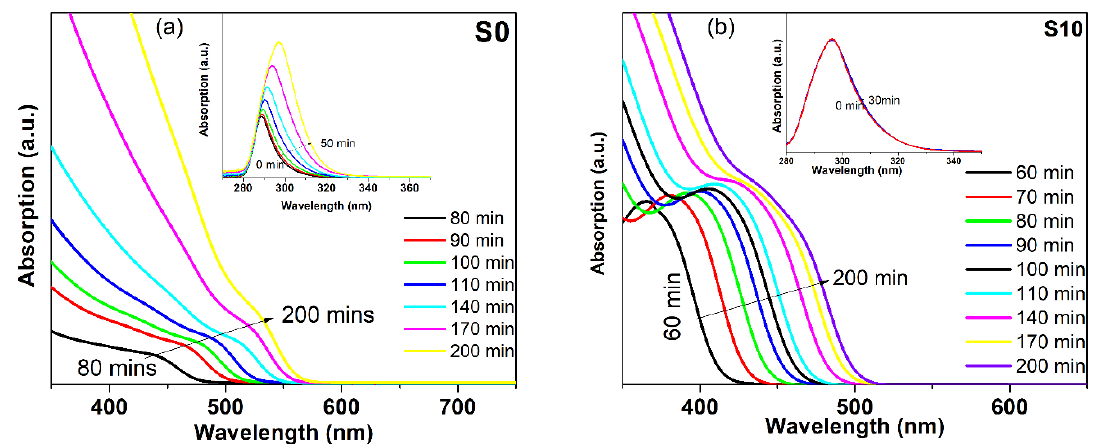
Figure 9. Optical absorption spectra during growth at different reaction times of: ( a ) binary CdSe (S0) and ( b ) ternary alloy with 10% of sulfur (S10).